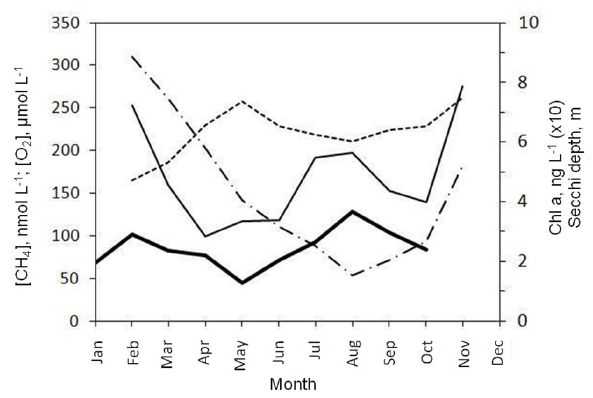
Fig. 5. Mean seasonal variability of O 2 (dashed dotted line), chloro- phyll (thin black line), Secchi depth (dashed line) and CH 4 (bold line) at 25m at Boknis Eck. The data from 2006–2008 were aver- aged to yield mean monthly values and smoothened with a 3-point moving average. Note that the CH 4 data were shifted back by one month.